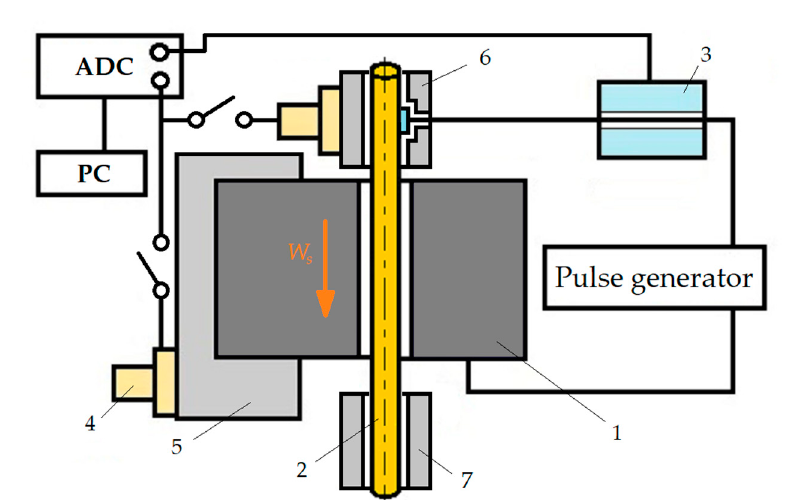
Figure 3. The layout of the sensors on the machine for electrical discharge machining of nanocomposites: ( 1 ) is a ceramic workpiece; ( 2 ) is a wire tool; ( 3 ) is a current sensor; ( 4 ) is accelerometers; ( 5 ) is a fastening system; ( 6 ) is an upper wire guide; ( 7 ) is a lower guide; ADC is the analog-digital converter; PC is the personal computer; W s is the direction of wire rewinding.